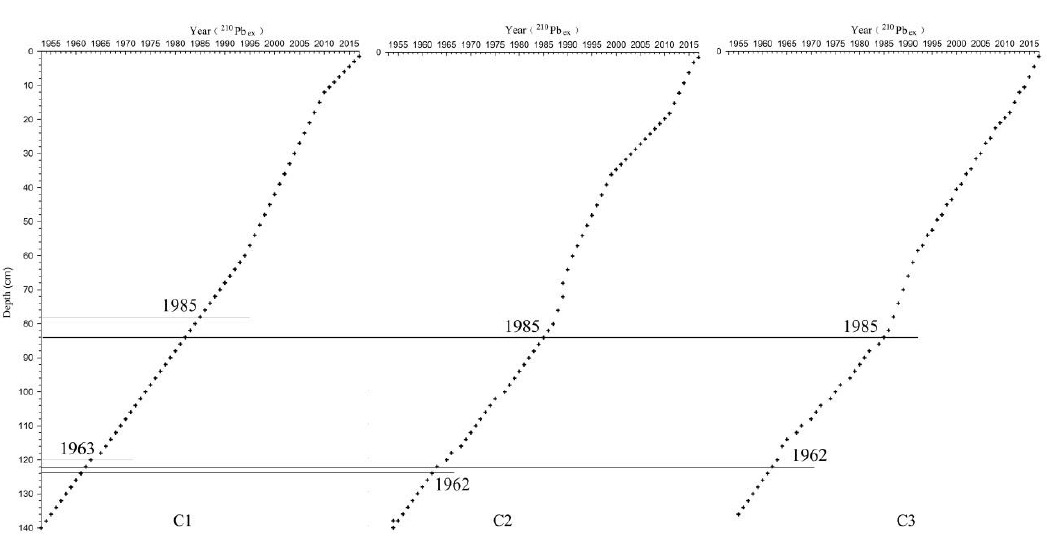
Figure 3. The dating analysis results of 210 Pb ex.